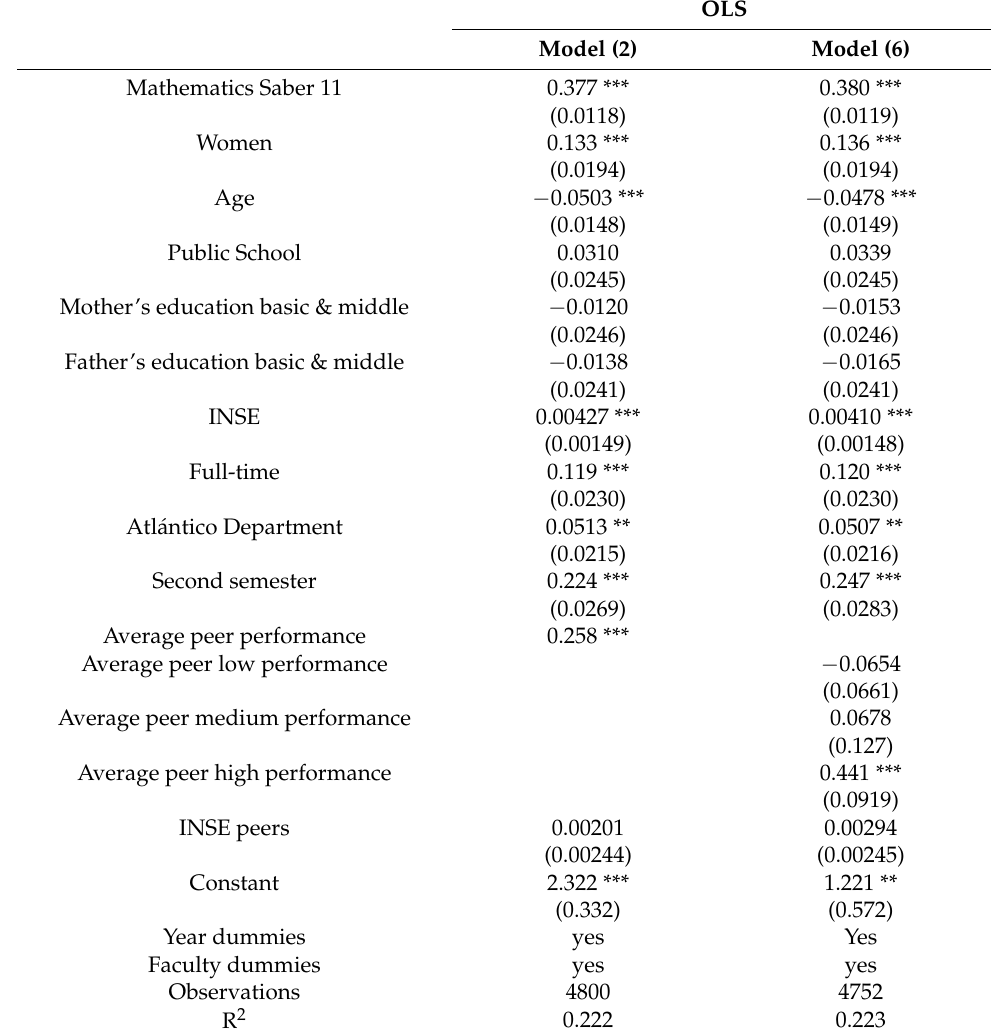
Table A2. Peer effects on academic performance in Calculus I—INSE.